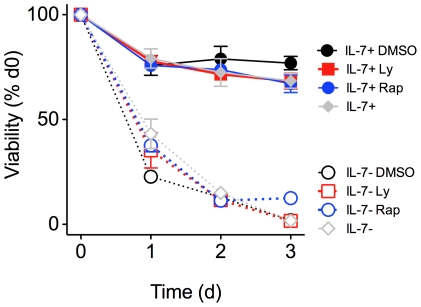
Viability of naïve CD8 T cells is not affected by blockade of PI3K or mTOR.Cells were cultured in RPMI containing standard Glu and aa nutrients and, where indicated, the inhibitors LY294002 (Ly) (10 µM) or rapamycin (Rap) (20 nM), or the vehicle control (DMSO) were added. Percentage of surviving CD44lo CD8+ T cells was normalized to the percentage of live CD44lo CD8+ T cells on day 0. Error bars indicate SD of technical replicates. Results are representative of three independent experiments.